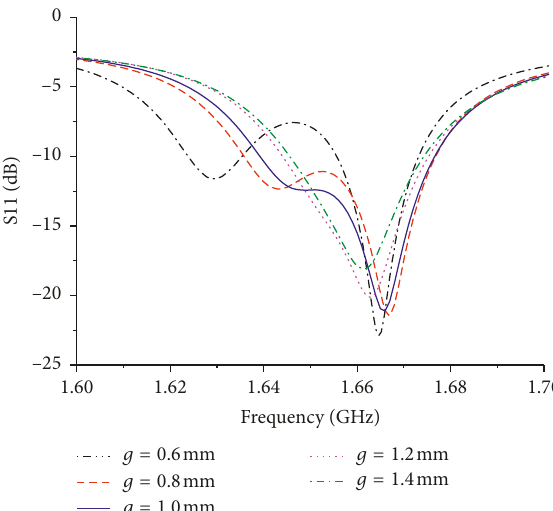
Figure 4: Antenna S11 when tuning the C-shaped parasitic strip length l 4.